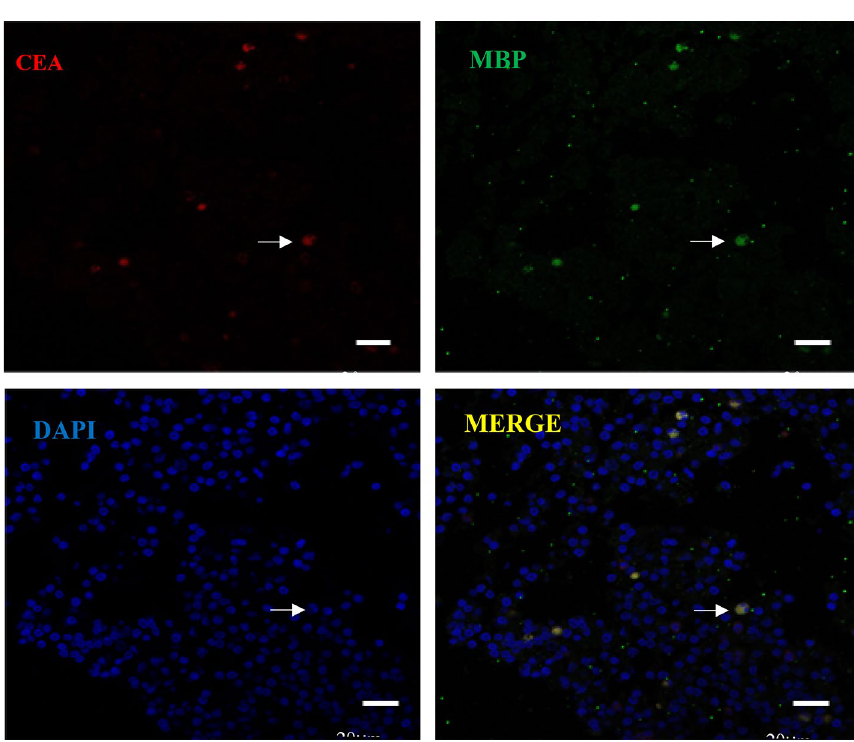
Figure 4. Lung section with a MBP–positive cell colabeled with CEA antigen localized on Cytoplasm, as indicated by the arrow. Scale bars = 20